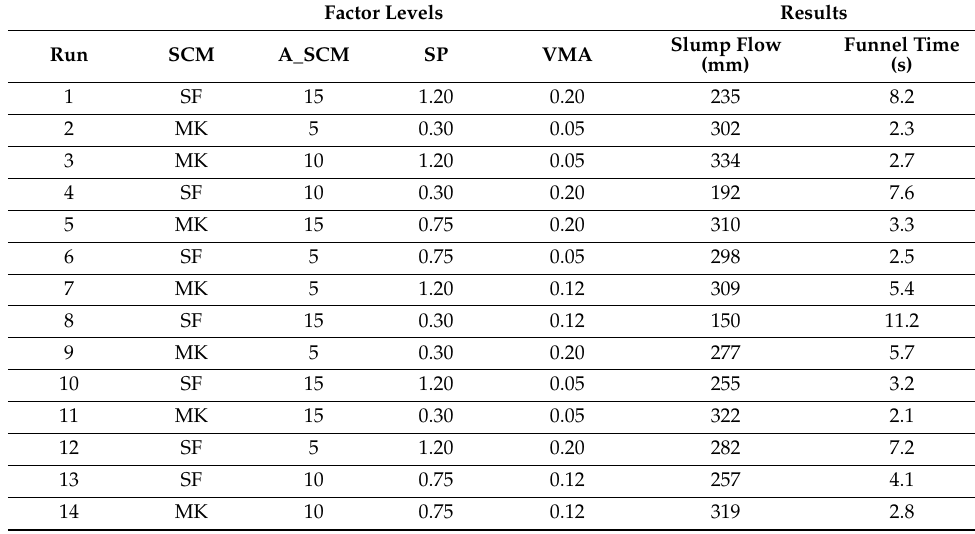
Table 5. Design matrix and the results on slump flow spread and V-funnel